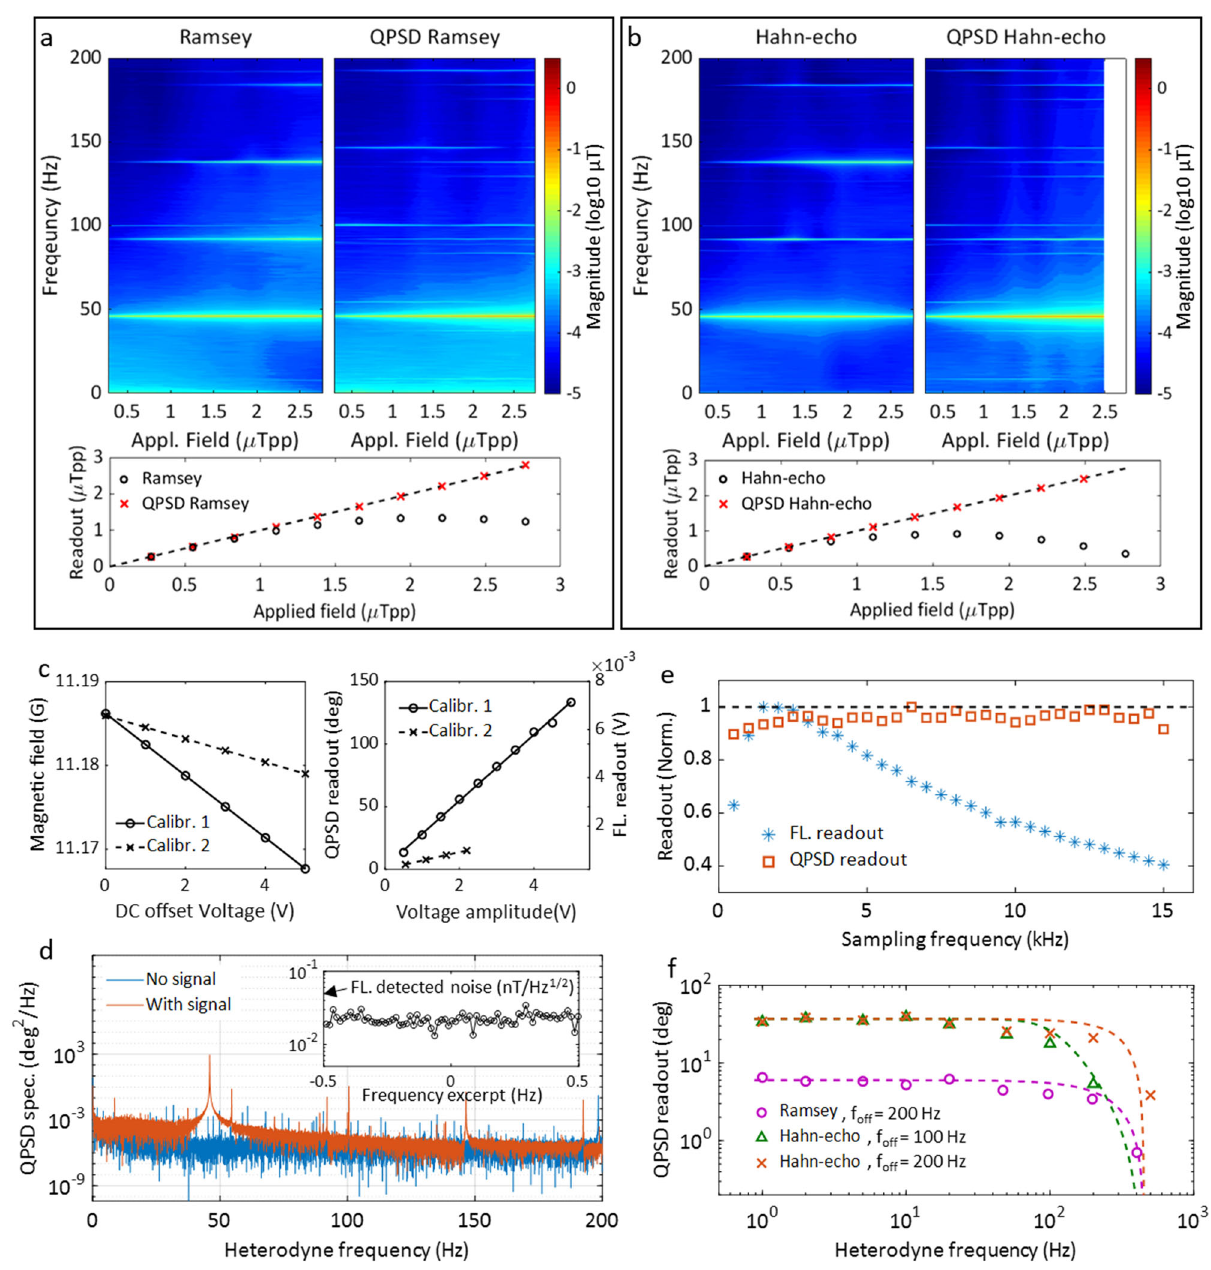
Fig. 2 | Sensing performance of the QPSD. a Spectra and linearity comparison of the fl uorescence readout and QPSD readout in Ramsey measurements. The mea- suredresultsofthetworeadoutschemesarebothplottedunderthespectra,while the dashed line shows the amplitudes of applied fi elds. b Spectra and linearity comparison of the fl uorescence readout and QPSD readout in Hahn-echo mea- surements. c Calibrationoftestcoilsandthesensorreadouts.Calibr.1corresponds to the QPSD readout and Calibr. 2 corresponds to the fl uorescence readout. The test coil is moved between the two measurements for veri fi cation. d The noise